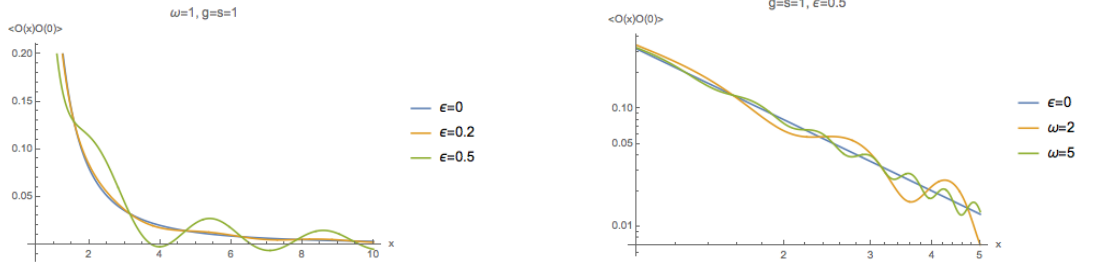
+ (cid:15) 2 (cid:14) hO ( x ) O (0) i for the oscillating (0)